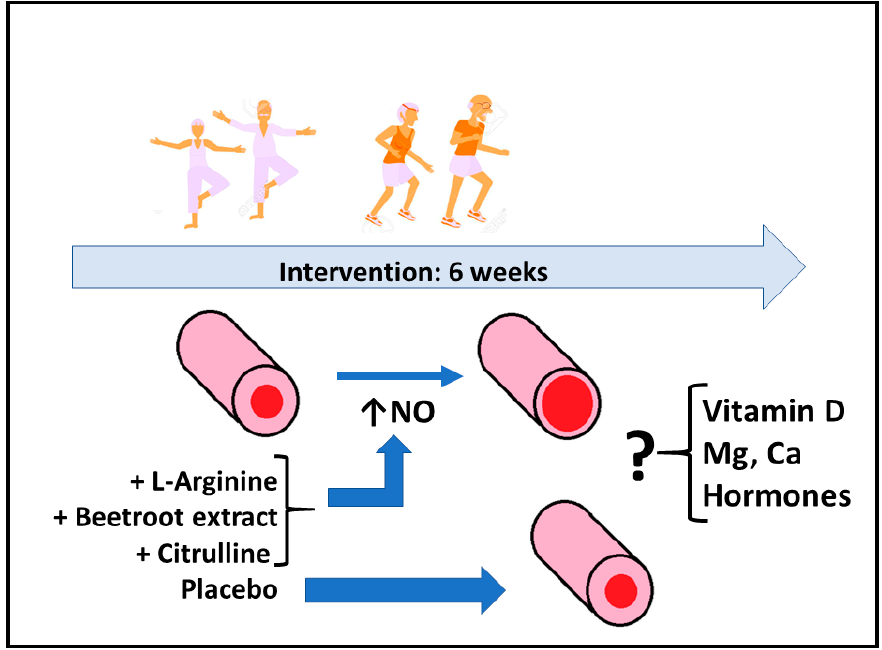
Figure 1. Scheme of the study hypothesis (see text for more details).